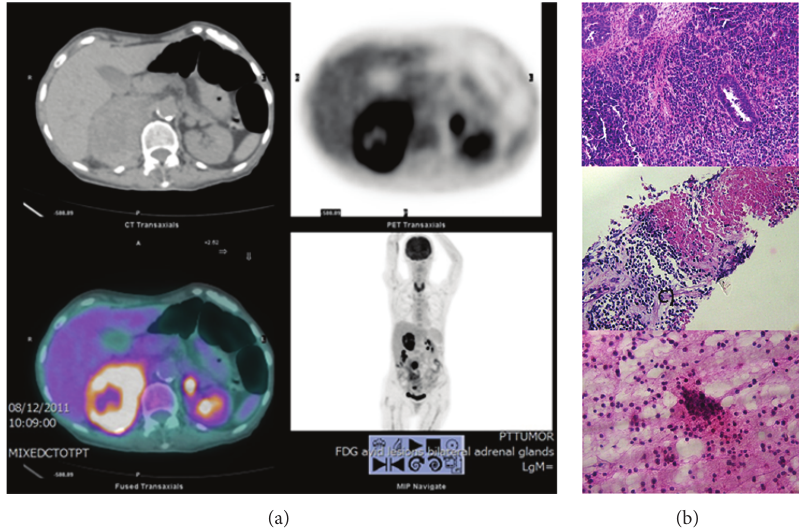
Figure 1: Bilateral adrenal gland metastases from an endometrial cancer primary. (a) Imaging of the adrenal metastases. FDG-PET CT scan images revealed enlarged adrenal glands with increased FDG uptake in both adrenal glands. The upper panels show transaxial CT (left) and FDG-PET (right) images of the adrenals. The lower panel on the left shows a fused CT/ FDG-PET transaxial image, and the lower panel on the right shows a coronal image of the FDG-PET scan. (b) Histological confirmation of the adrenal metastases. The top panel shows a hematoxylin and eosin (H&E) stained image of the primary endometrial tumor (original magnification × 200), with predominantly solid proliferation and scattered endometrial glands. The middle panel is an H&E stain of a core biopsy from the right adrenal gland mass (original magnification × 100) showing viable discohesive tumor cells (lower field) and a large area of confluent tumor necrosis (upper field). The lower panel is an H&E touch cytologic preparation of the right adrenal biopsy (original magnification × 400), showing a cluster of round tumor